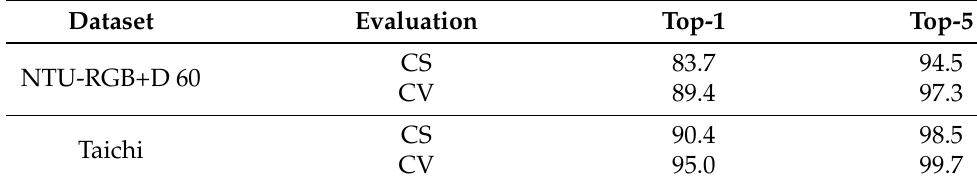
Table 1. Action recognition accuracy (%) on the NTU-RGB+D 60 and Taichi datasets.